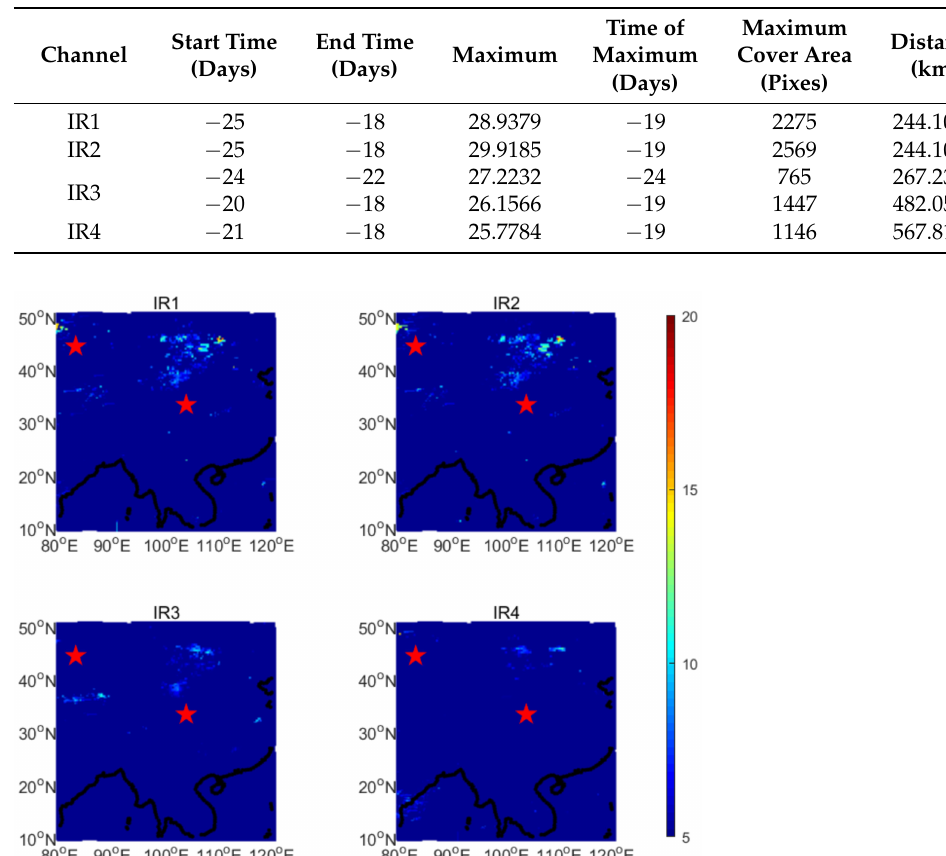
Table 3. The spatial–temporal characteristics of anomalies before the Sichuan earthquake.